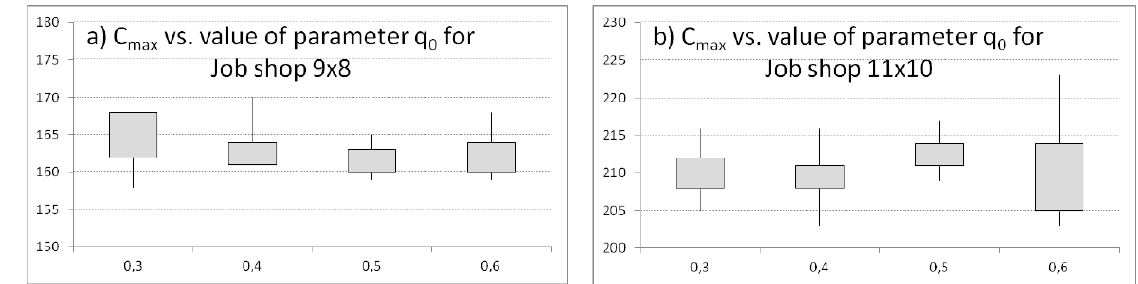
tasks: {7 8 6 9 5 2 4 3 1} for scheduling problem (9 × 8) and {10 8 7 6 11 9 3 4 1 5 2} for